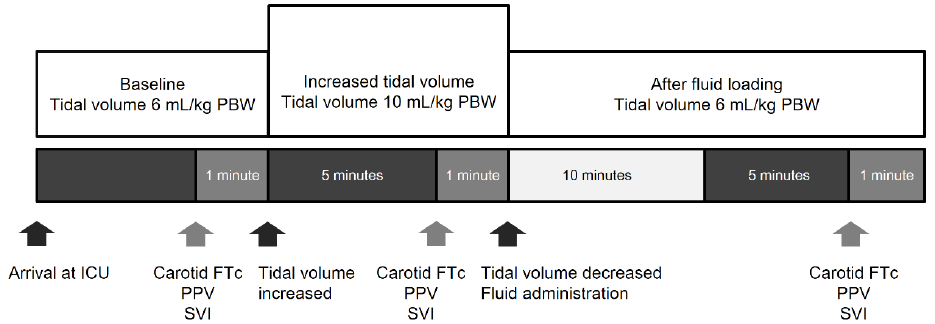
Figure 1. Study design. The arrows indicate the time points at which interventions or measurements were made. PBW = predicted body weight; PPV = pulse pressure variation; SVI = stroke volume